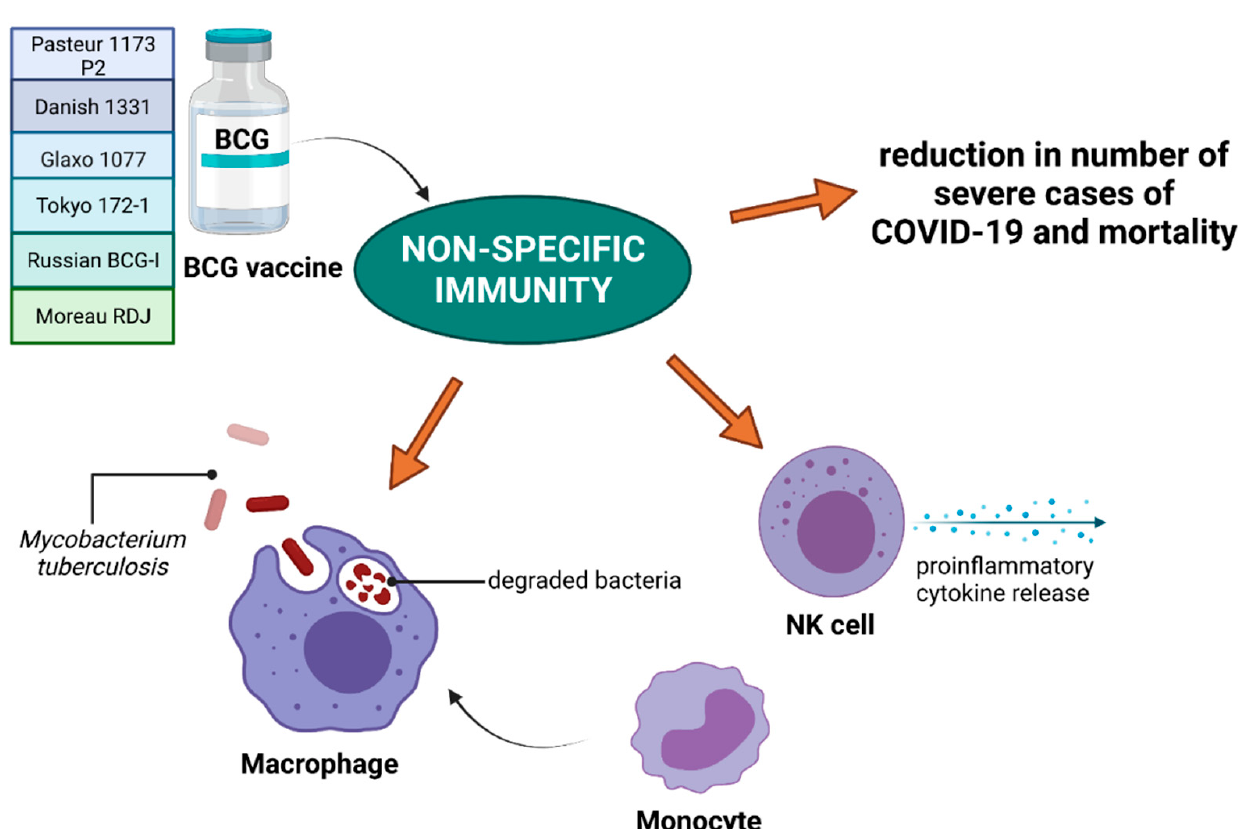
Figure 4. BCG vaccine against tuberculosis includes six strains: Pasteur 1173 P2, Danish 1331, Glaxo 1077, Tokyo 172-1, Russian BCG-I and Moreau RDJ. Apart from preventing tuberculosis, BCG vaccine exhibits immunomodulatory effects, resulting in activation of non-specific immunity, macrophage activation and proinflammatory cytokine release by NK cells. Such response after vaccination was shown to be associated with reduction in severe cases of COVID-19 and COVID-19-related mortality. Abbreviations: BCG—Bacillus Calmette–Gu é rin; NK—natural killer. Created with BioRender.com (accessed on 8 May 2021).